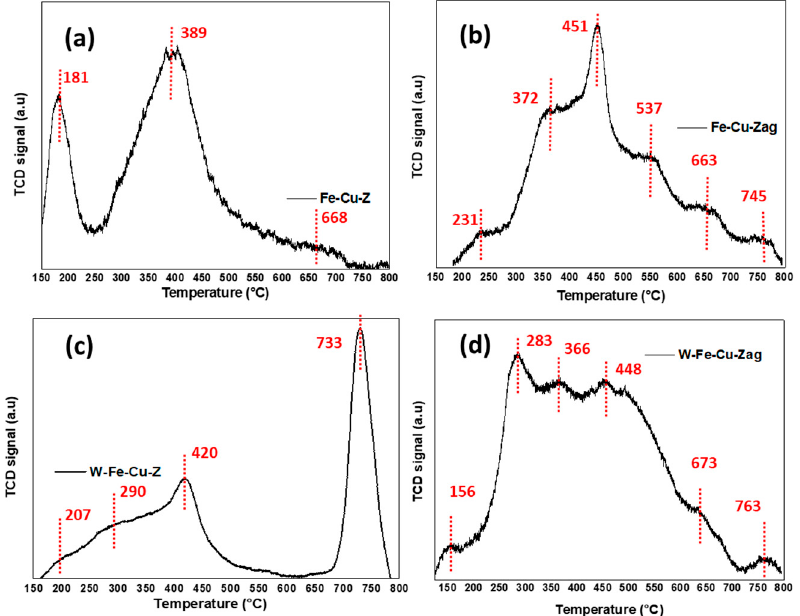
Figure 8. H 2 -TPR profiles of ( a ) Fe-Cu-Z, ( b ) Fe-Cu-Zag, ( c ) W-Fe-Cu-Z, and ( d ) W-Fe-Cu-Zag cat- alysts.